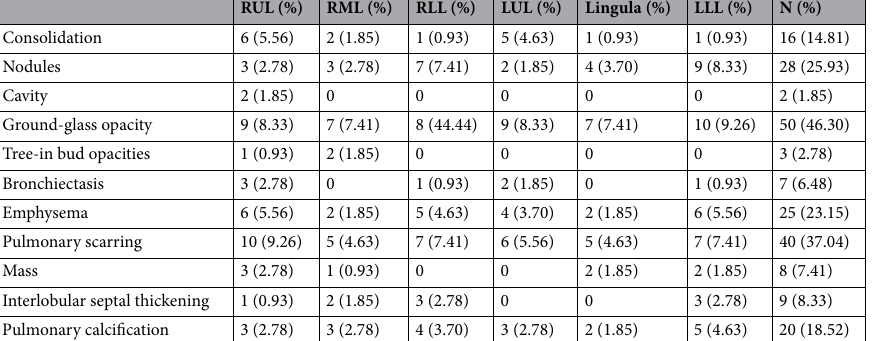
Table 2. Number and location of main pulmonary CT manifestations in the 108 pulmonary segments of BCG infection (n = 18). RUL right upper lobe, RML right middle lobe, RLL right lower lobe, LUL left upper lobe, LLL left lower lobe, Lingula left lingula